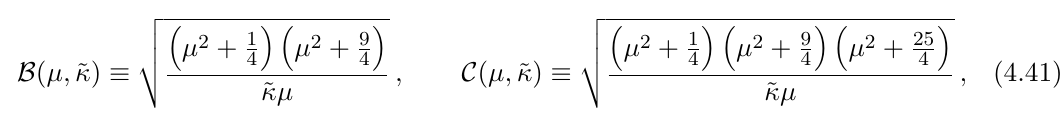
Figure 8 . The CC signals in the h γ λ potential ˜ κ . For the purpose of demonstration, here we have only shown two helicity choices, namely λ 1 = − 2 , λ 2 = +2 (left) and λ 1 = λ 2 = +2 (right). The other helicities can also be calculated in a similar fashion. The correlator is normalized by ( k 3 /k 1 ) 9 / 2 k 6 the upper panels showing the full result and the lower panels showing the oscillatory CC signal only. The blue solid lines correspond to the analytical cut result while the red dashed lines correspond to numerical results (the signals are filtered from the total numeric integration result using high-pass filters with a Blackman window